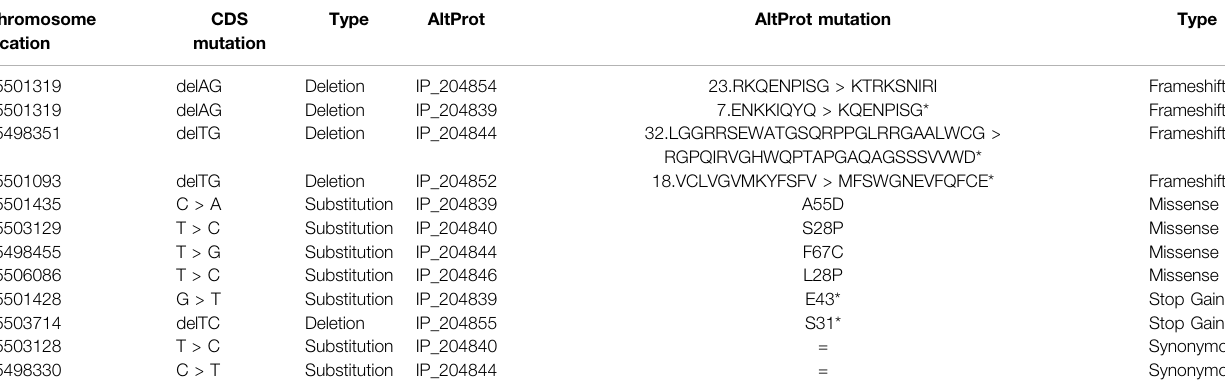
TABLE 3 | Demonstration of the mutations (TCGA database) impacting the ncRNA MALAT1 in the GBM and the impact that these mutations may have on the AltProts predicted as resulting from this transcript, described as having a speci fi c variation in the GBM. Chromosome